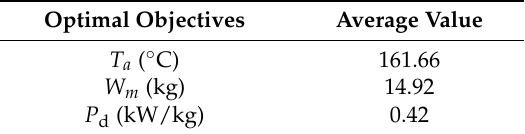
Table 9. Average value of optimal objectives.